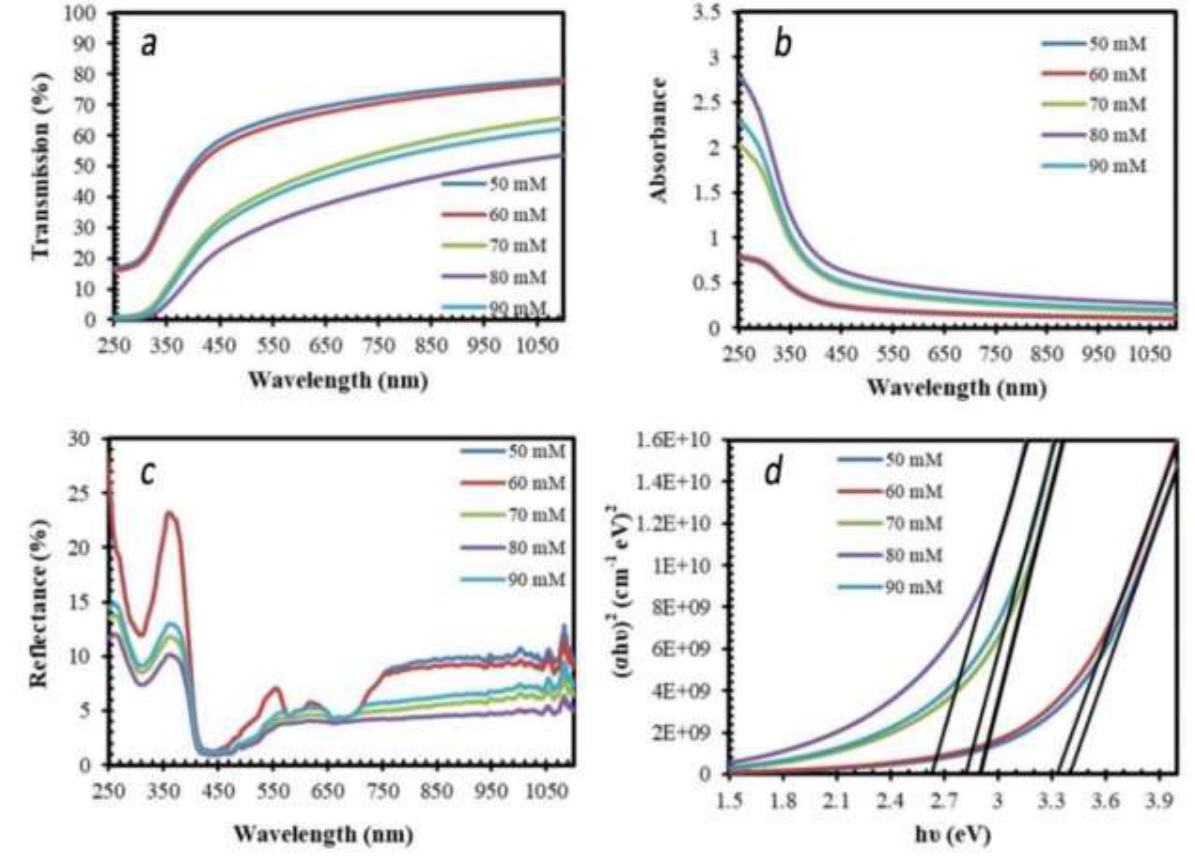
Figure 1: (a) optical transmittance, (b) absorbance, (c) Reflectance, (d) Energy gap of WO3 thin films at variation molarity